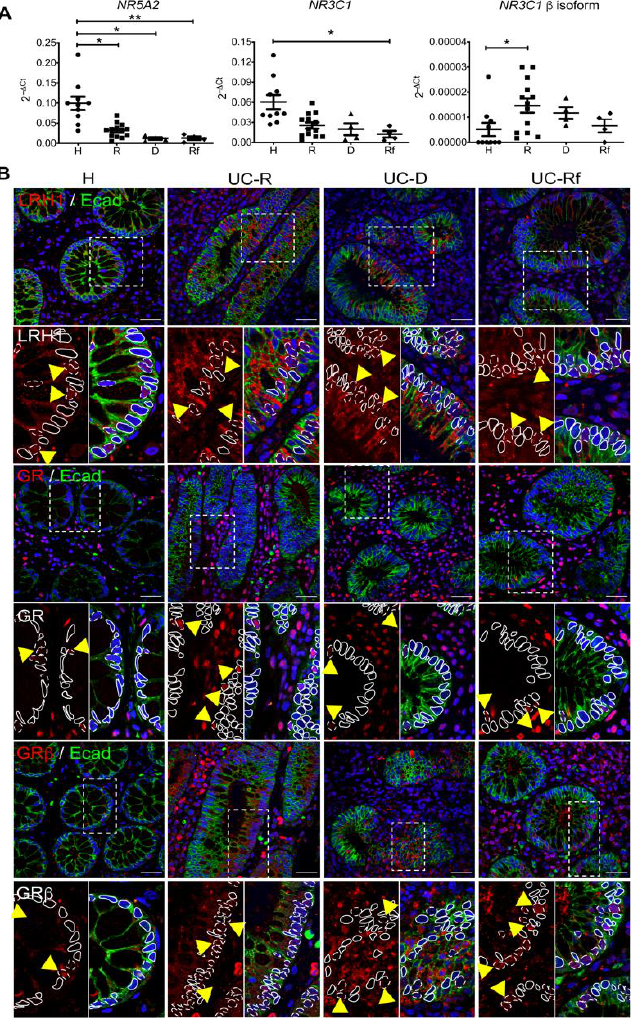
Figure 2. LRH-1 and GR β are upregulated in intestinal mucosa from patients with impaired GC response. ( A ) Transcript levels (relative to PPIB ) of NR5A2, NR3C1 and NR3C1 isoform β in intestinal mucosa from healthy controls (H), responders (R), dependent (D) and refractory (Rf) UC patients by RTqPCR. Transcript levels (relative to PPIB ) of NR5A2 , NR3C1 and NR3C1 isoform β ; differences between group medians were assessed using Kruskal–Wallis with Dunn’s post-test and Pearson correlation performed. Each point represents an individual value: non-inflamed (circles), responders (squares), dependents (triangles) and refractory (diamonds), * p < 0.05; ** p < 0.01. ( B ) Representative immunoreactivity of LRH-1, GR and GR β isoform (red) in paraffin-embedded PFA-fixed sections of intestinal mucosa biopsies taken from healthy individuals and active UC patients according to their GC response by tissue array. E-cadherin (Ecad) co-localization (green) was used for epithelium recognition. In the zoomed image indicated with dashed line and yellow arrow: positive nuclear stain; solid line: negative nuclear stain. Objective 60 × , scale bar 30 µ